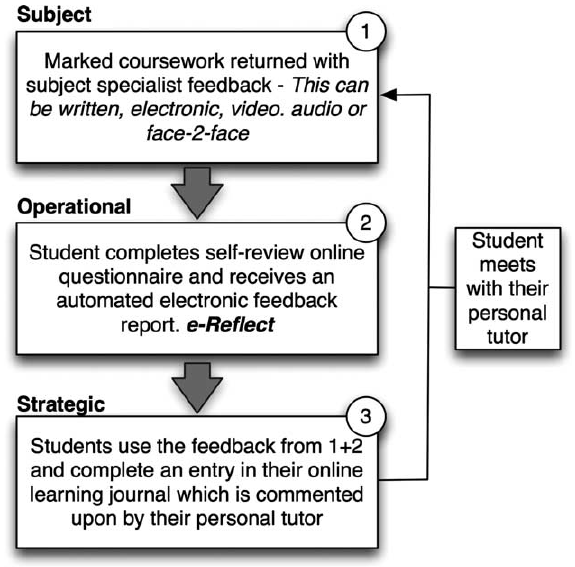
Figure 1. The SOS Model of student